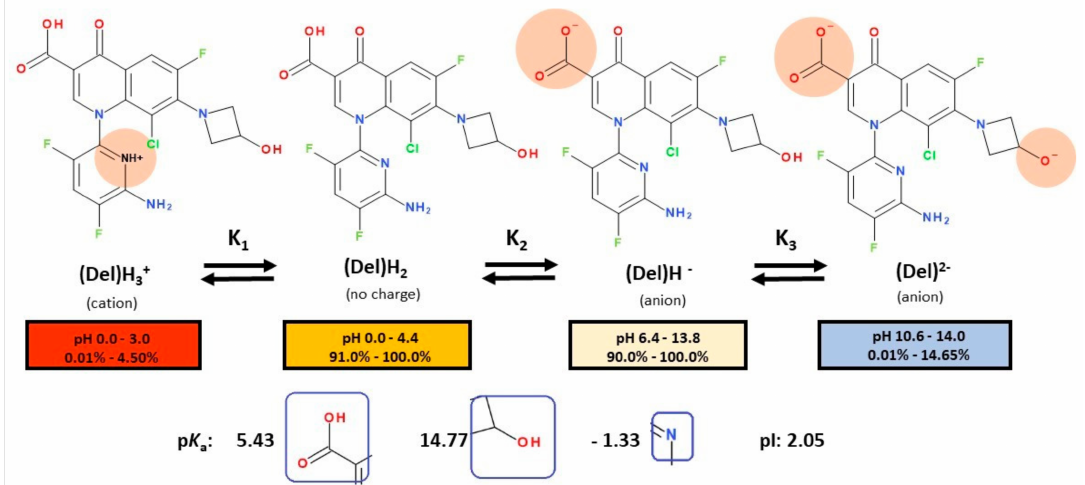
Figure 6. The macroprotonation scheme of delafloxacin and the step-wise protonation constants K 1 , K 2 and K 3 . The carboxylate, hydroxyl, and the pyridine ring’s nitrogen atom (N1 position) are the most acidic, respectively, the most basic functions. All data were calculated with the MarvinSketch 20.20.0 version from ChemAxon